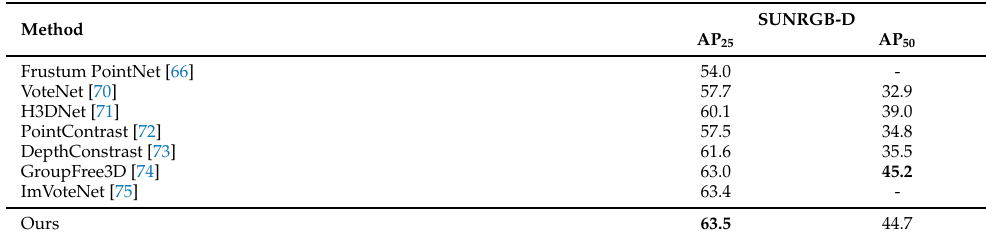
Table 9. Transfer learning based on state-of-the-art detection frameworks. The bold denotes the best